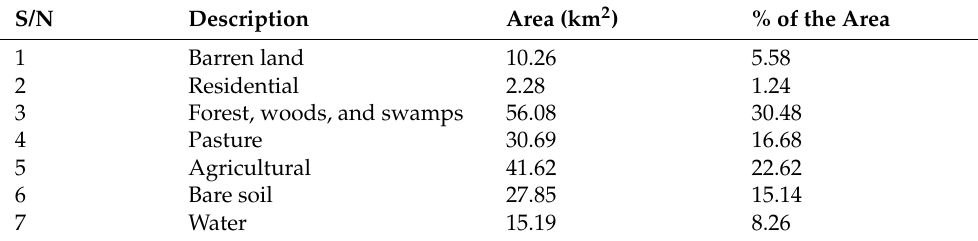
Table 6. Data on land